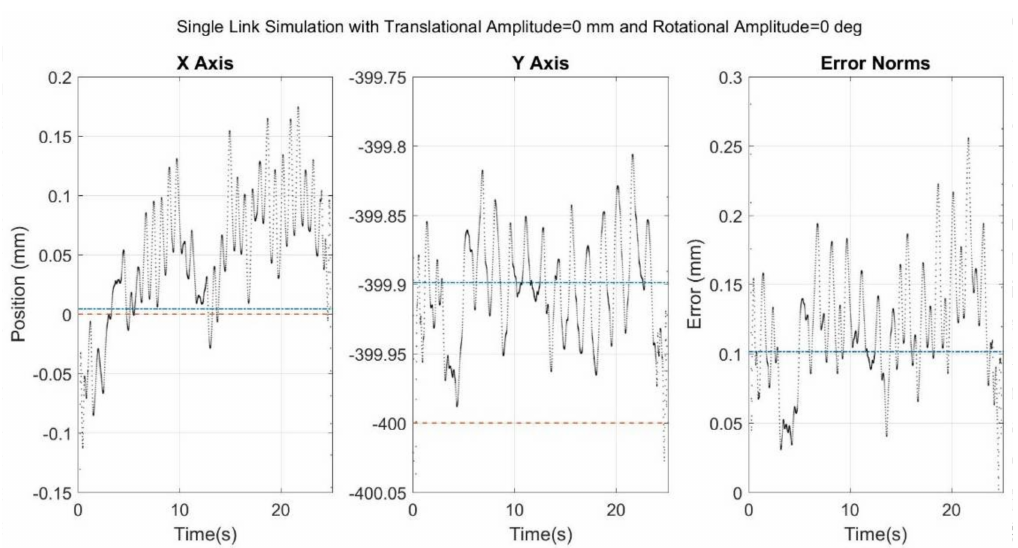
Figure 6. Results for simulation run with only noise added to a rigid link. Black dots refer to SFO, blue dash-dots to SOM, and red dashes to the